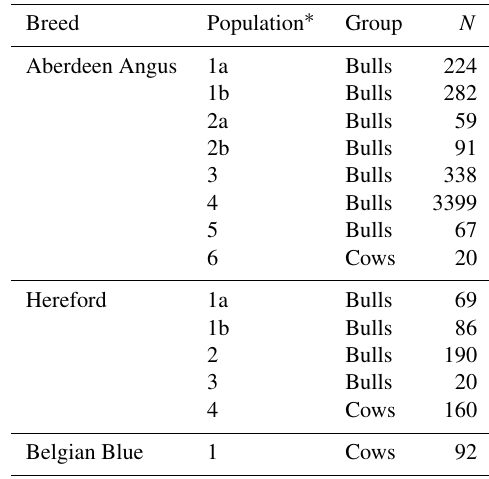
Table 1. Description of the research material.